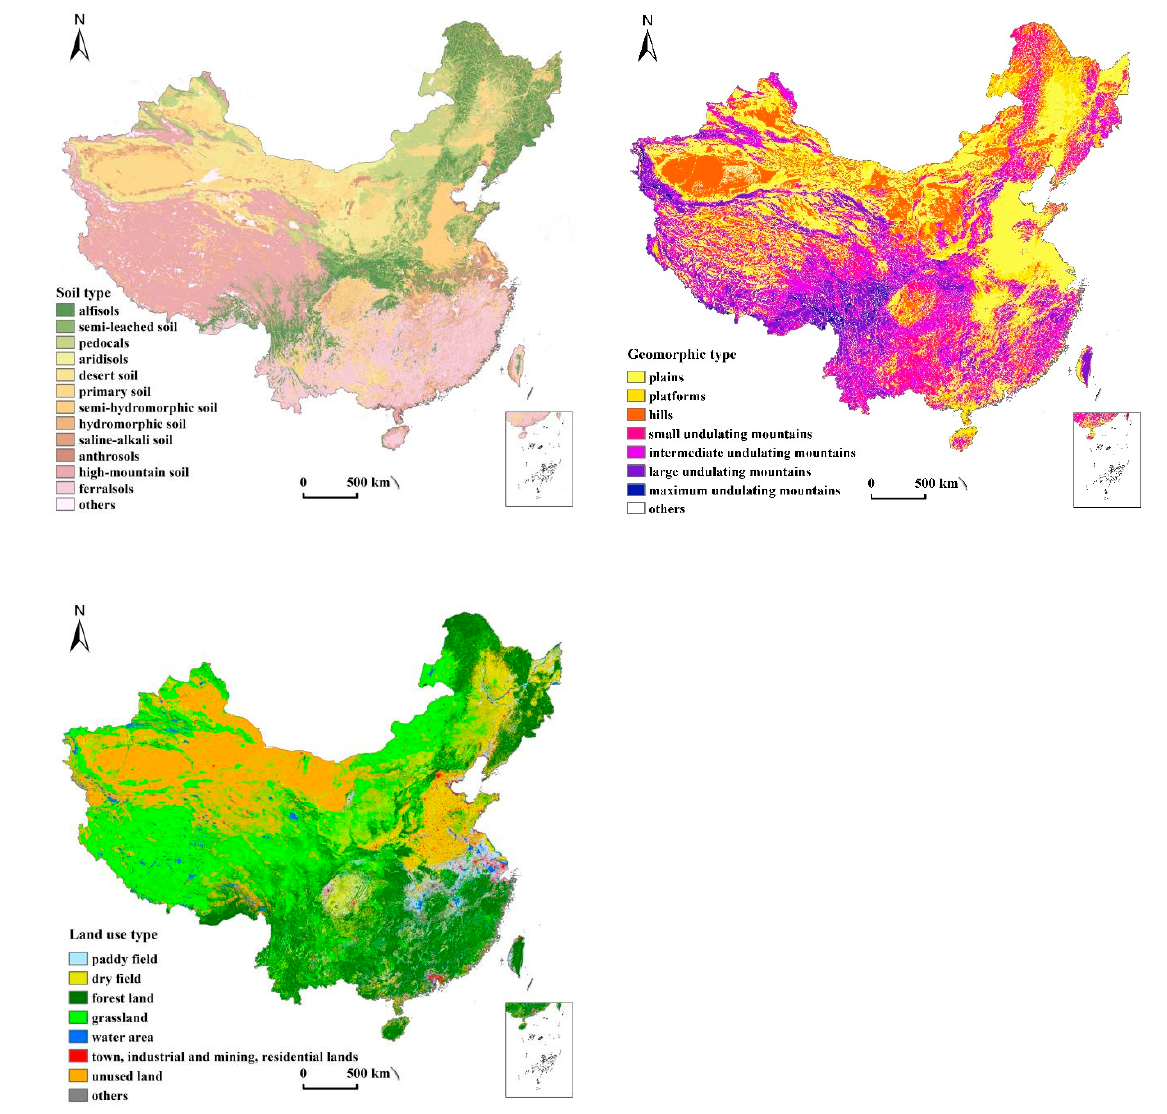
Figure 2. Distribution of environmental factors in the study area.